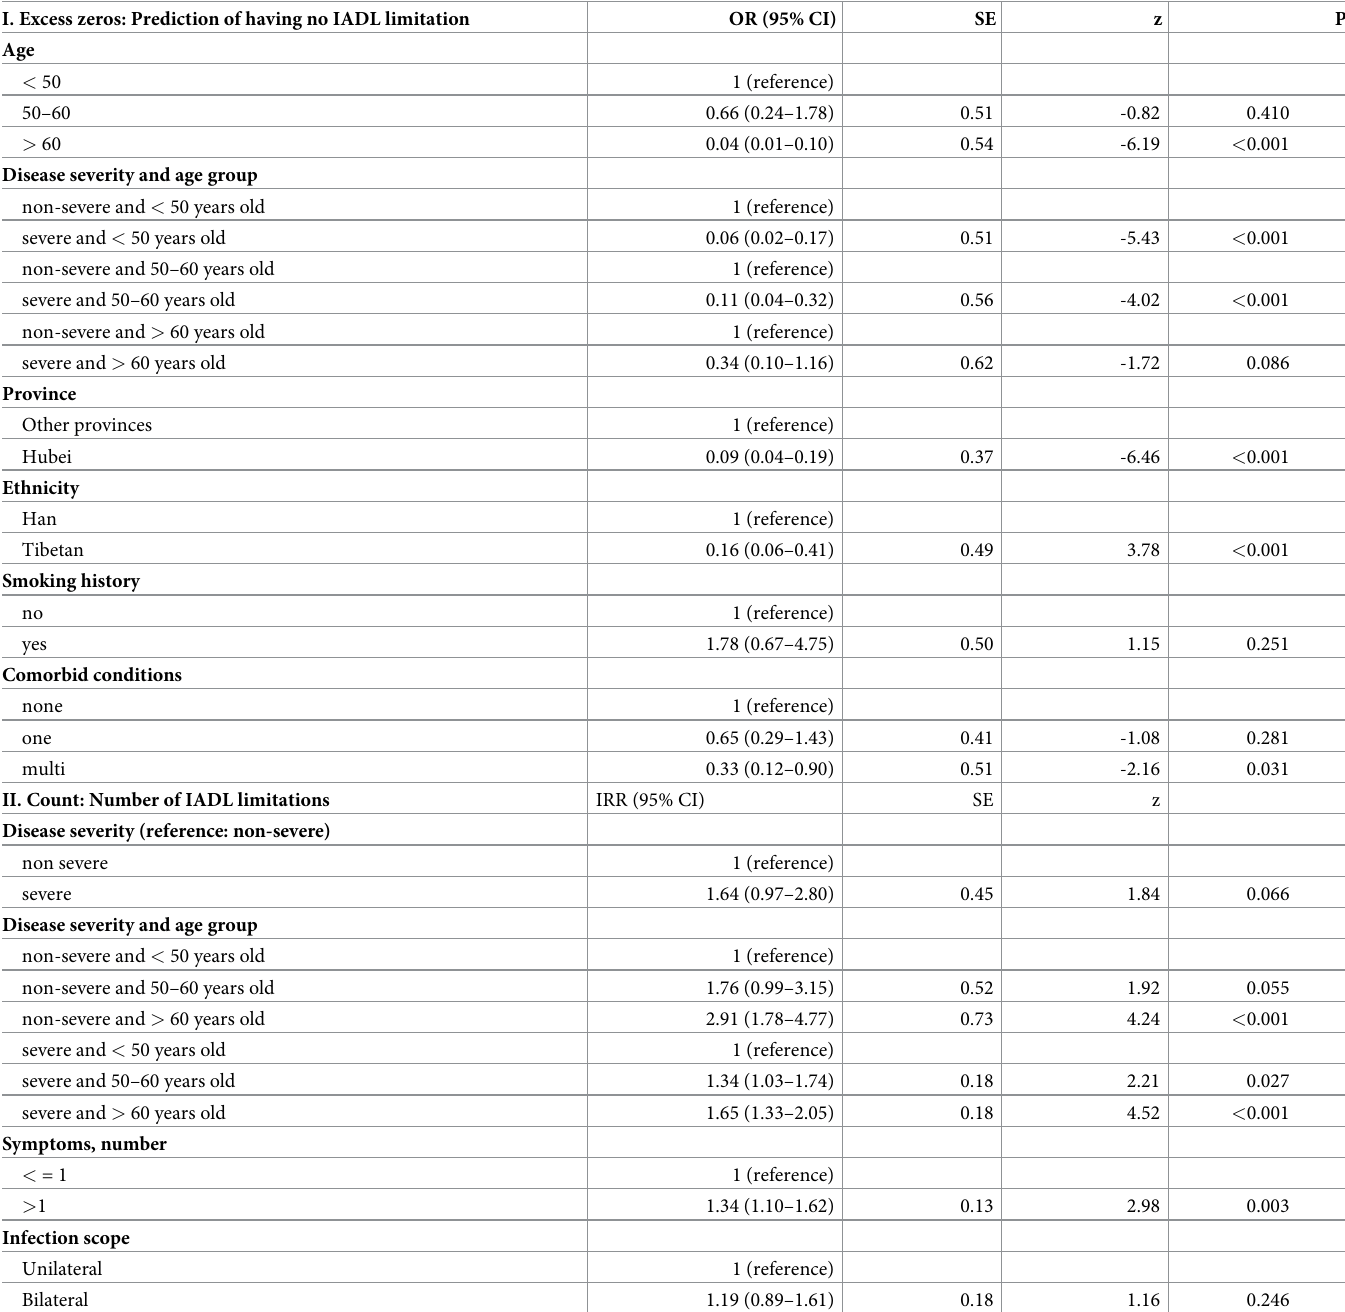
Table 2. Results from zero-inflated Poisson regression of number of IADL limitations on potential risk factors (n =